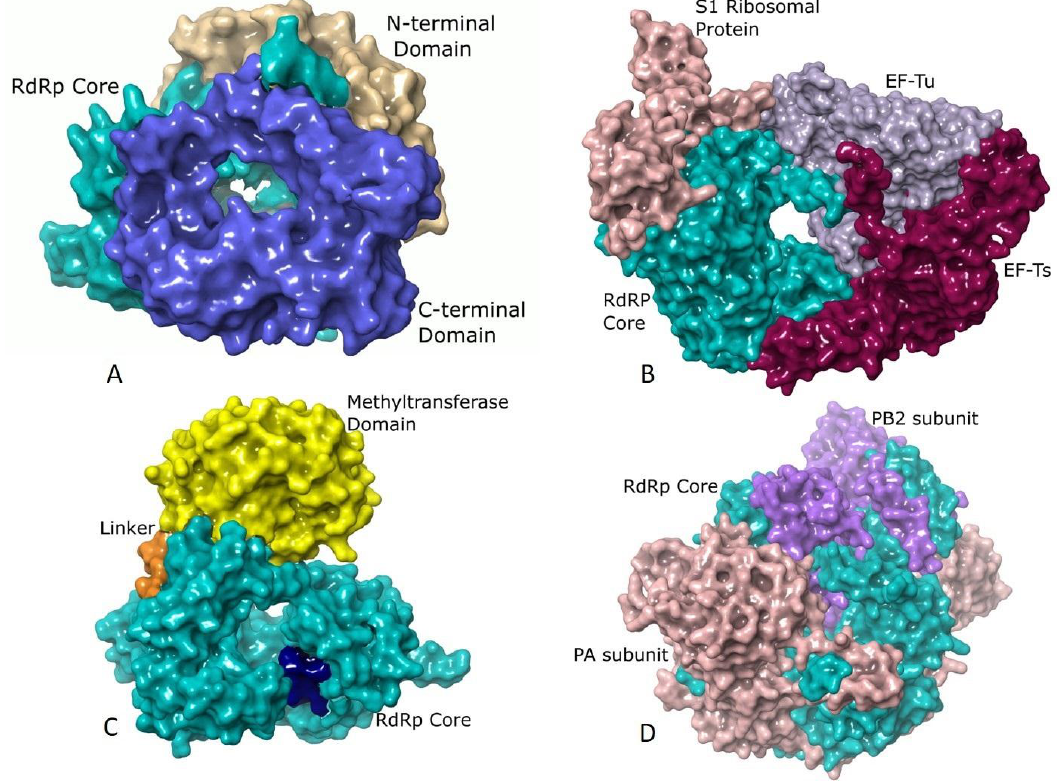
Figure 2. Additional structural elements of different RdRps: ( A ) The surface representation of RdRp of Mammalian orthoreovirus 3 (MRV3) (PDB ID: 1n35) [29] showing the core (residues 371–890, colored turquoise) in association with the C-terminal bracelet domain (shown in blue) composed of residues 891–1267 and the N-terminal domain (depicted in tan) spanning residues 1–370. While the N-terminal domain restricts the movements of the thumb and fingers subdomains, the C-terminal domain resembles the sliding clamp of DNA polymerases in structure and has a positively charged opening of 20 Å diameter. ( B ) Q β polymerase (PDB ID: 4r71) [72] shown in surface representation with the core RdRp ( β -subunit, Chain B, residues 1–571) colored turquoise, host translation elongation factors EF-Tu (Chain A, residues 2–1393, colored mauve) and EF-Ts (Chain C, residues 4–1394, colored dark magenta) and the S1 ribosomal protein (Chain E, residues 1–171, colored rosy brown). The extensive interactions of EF-Tu with the β -subunit is believed to aid in rapid separation of the duplex RNA that is formed during polymerization thereby allowing exponential amplification of phage genome. The S1 protein is involved in recognizing (+) strand of Q β [72]. ( C ) The RdRp of Dengue virus (DENV) (PDB ID: 4hhj) [73] rendered in surface showing the core (residues 272–900, colored turquoise) with the priming loop residues 789–805 shown in dark blue, the methyltransferase domain (residues 1–262) in yellow and the linker (residues 213–271) in orange. The methyltransferase domain is an essential part of the replication machinery that catalyzes 5 (cid:48) -RNA capping and methylation during viral genome replication. ( D ) The Influenza B virus (FluB) replicase (PDB ID: 4wrt) [50] consists of the PA (Chain A, residues 1–726, colored sandy brown), PB1 (Chain B, residues 1–752, colored turquoise) and PB2 (Chain C, residues 1–770, colored purple) domains are shown in surface representation. PB1 has polymerase activity, PB2 possesses a cap-binding domain and PA contains an endonuclease domain. The PA and PB2 domains lie towards the N- and C-terminal domains of PB1,